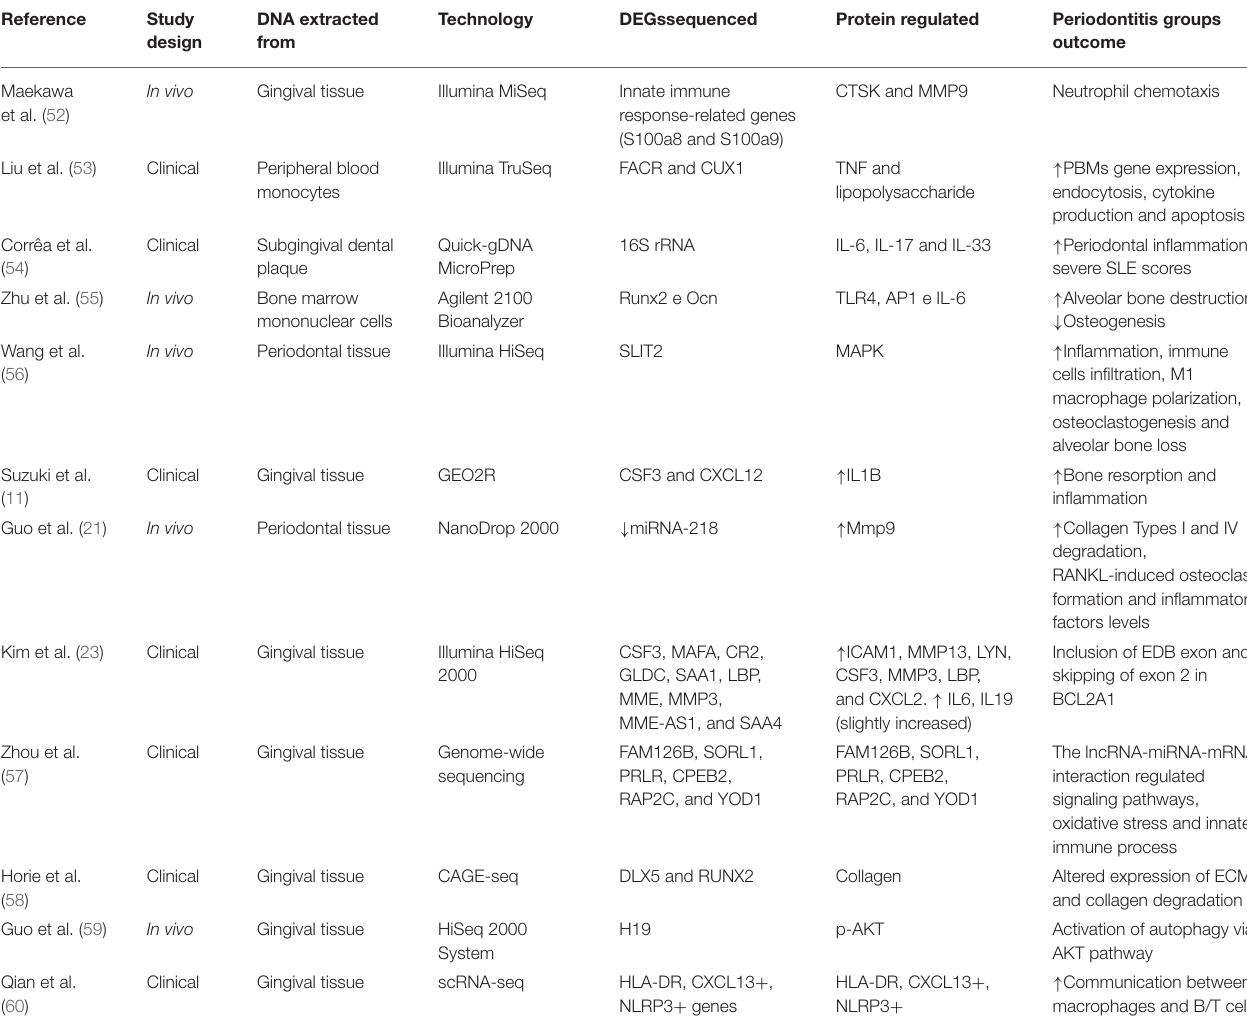
TABLE 1 | Transcriptomics in periodontal inflammation by RNA sequencing